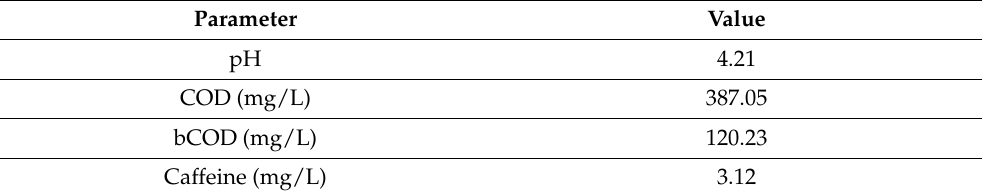
Table 2. Characteristics of coffee wastewater (after mixing with synthetic wastewater) in this